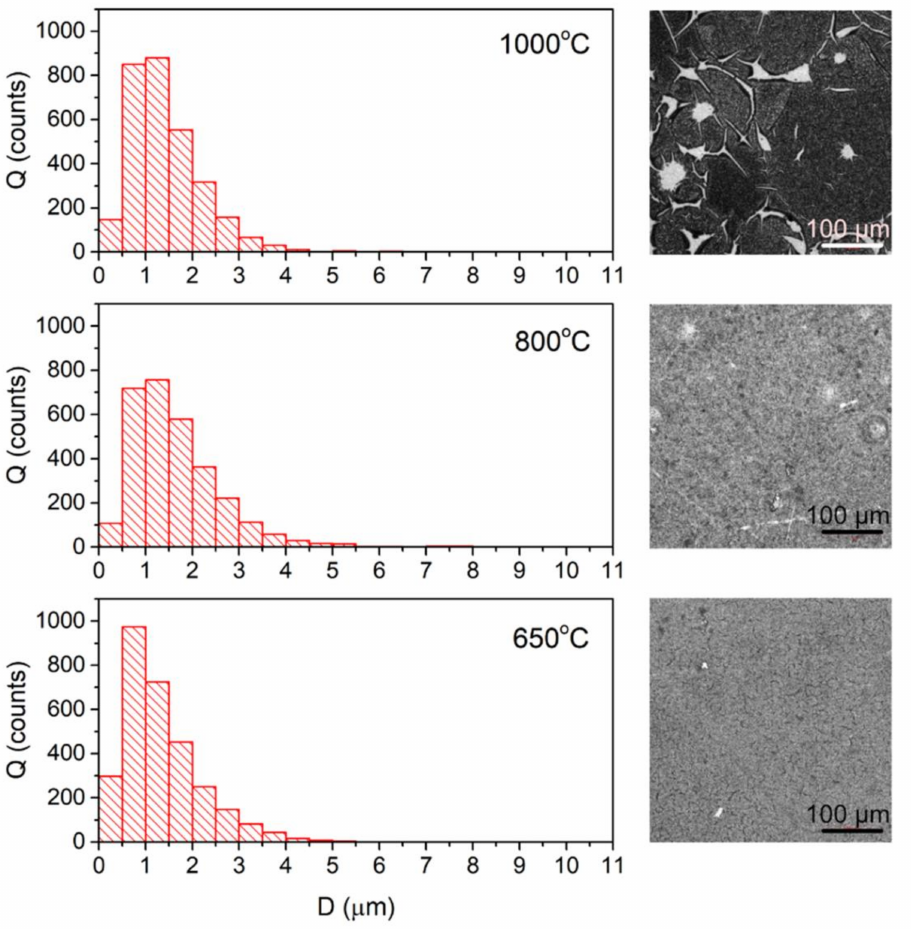
Figure 2. Micrographs made with confocal microscopy in material mode and distribution of crystal- lite